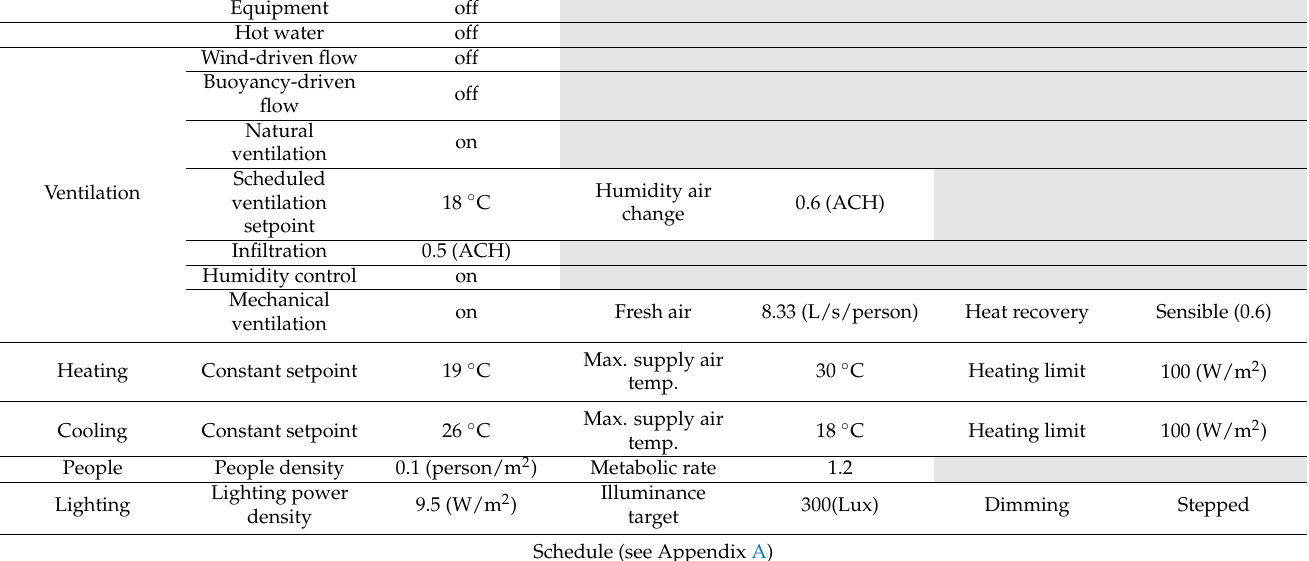
Table 2. Parameters in EnergyPlus engine